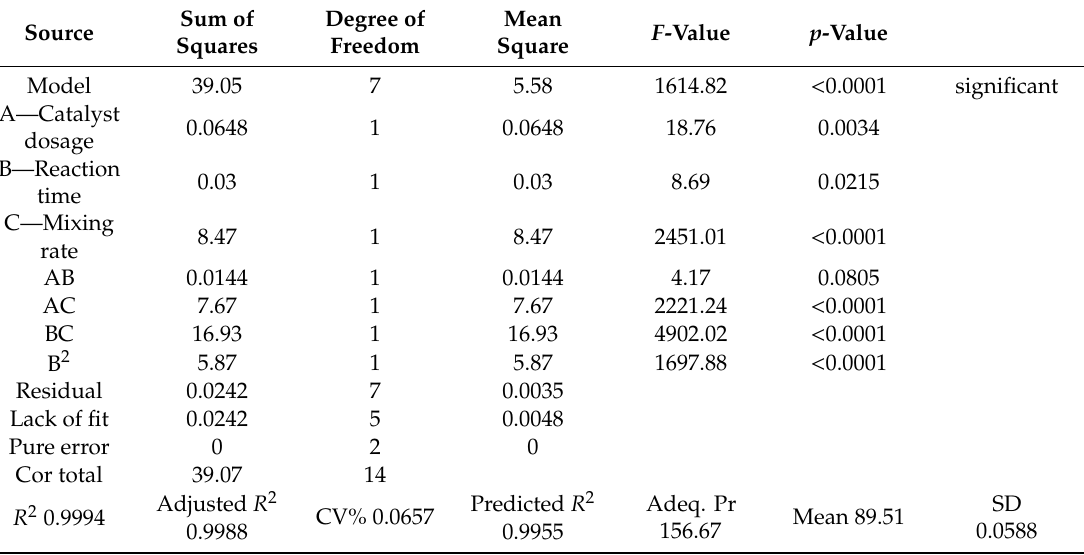
Table 5. ANOVA for COD removal by zeolite—reduced quadratic model. CV: coe ffi cient of variation.